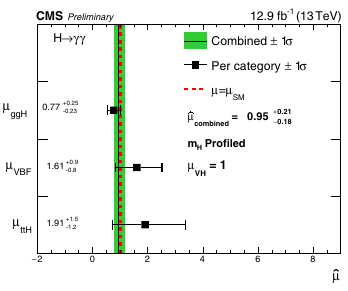
Figure 9. Signal strength modifiers measured for each process (black points) for profiled m H , compared to the overall signal strength (green band) and to the SM expectation (dashed red line)